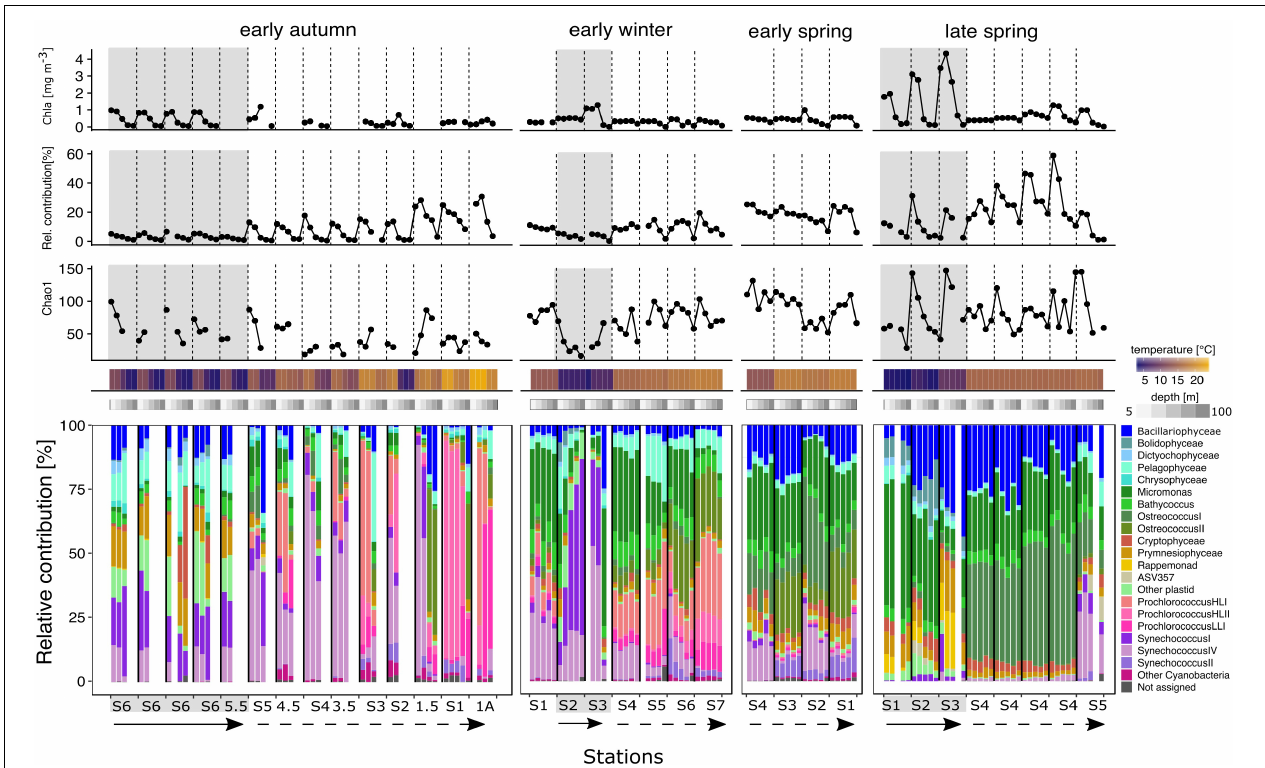
FIGURE 3 | Environmental metadata and stacked bar plots of the taxonomic relative contributions to the phytoplankton fraction for each station within each seasonal campaign. Top three panels: Chlorophyll a concentration (uppermost), phytoplankton relative contribution to the total sequences (middle) and Chao 1 richness (bottom). Data points in the three line graphs are aligned to the phytoplankton community composition representation below. Bottom panel: stacked barplot representing the relative contributions of the different taxonomic groups to the phytoplankton fraction. Bars are organized by station from left to right in a north to south direction indicated by the straight arrow (subpolar) and the dashed arrow (subpolar), except early winter where S2 was the most northern station. Only depths 5–100 m were analyzed and plotted for the phytoplankton fractions. Within each station, depths are organized in a descending order from 5 to 100 m in a left to right direction. Blank columns represent samples that did not overcome the minimal sequences threshold or where sample failed to generate amplicon sequences. Temperature and depth heatmap cells and data points in the three line charts correspond to the sample represented by the aligned barplot below these. Gray background shading indicates that the profile is biologically categorized as subpolar (physically located in the subpolar and temperate), while no shades represents subtropical (physically located in the subtropical and Sargasso